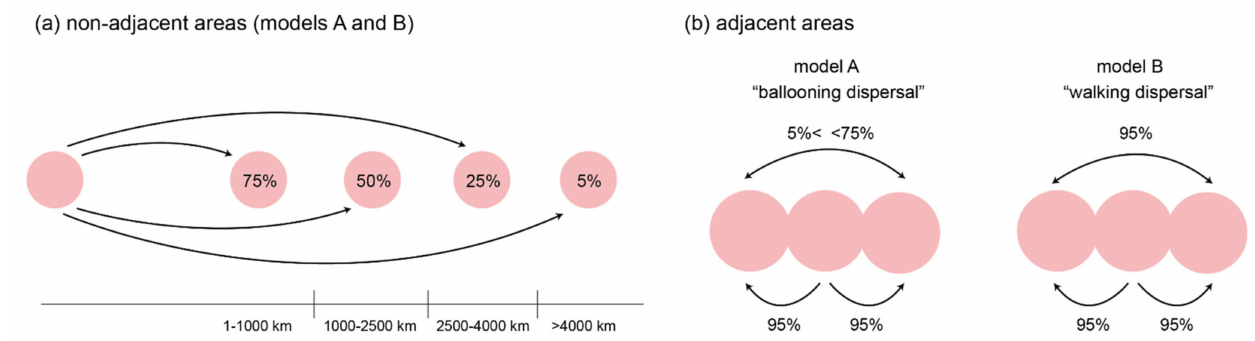
Figure 2. Methods of dispersal probability attribution. Each pink circle represents a geographical area. ( a ) For non-adjacent pairs of areas, both models attributed dispersal probabilities based on physical distances between the areas. Probabilities were inversely proportionate to the distance and binned into four categories. ( b ) When areas were in physical contact, model A attributed the maximal, 95% dispersal probability only between directly neighbouring areas, while indirectly connected areas were scored as non-adjacent pairs of areas. In contrast, model B treated all physically connected areas as a single area, attributing a 95% dispersal probability to all pairs of